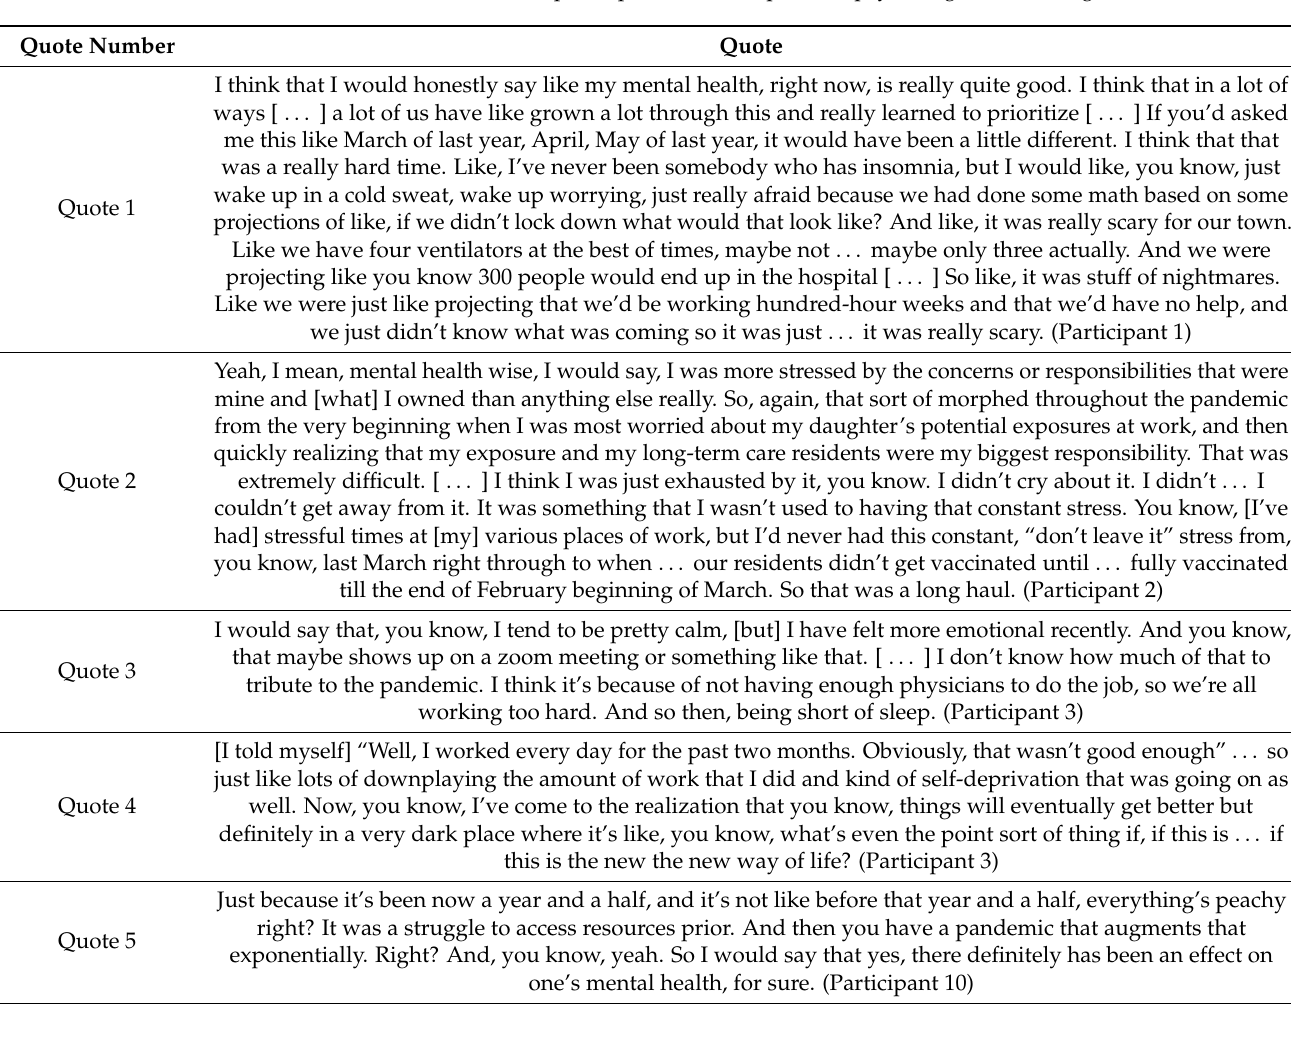
Table A2. Quotes from participants about impacts on psychological wellbeing.